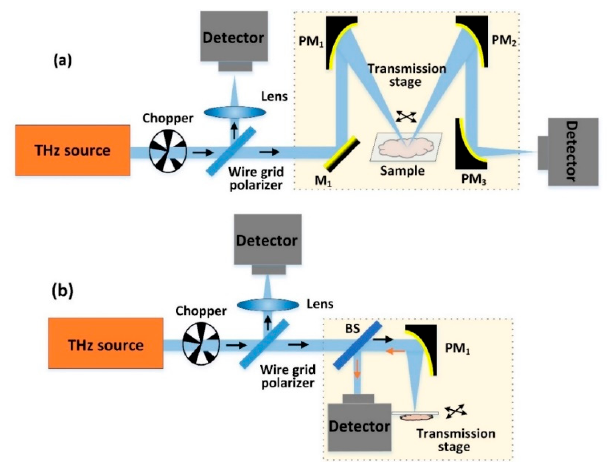
Figure 2. CW-THz reflection single-point scanning imaging system: ( a ) Obliquely incident; ( b ) Normal incidence. Here, BS stands for beam-splitter. The direction of the incident beam was marked with black arrows, and the direction of the reflected beam was marked with orange arrows.